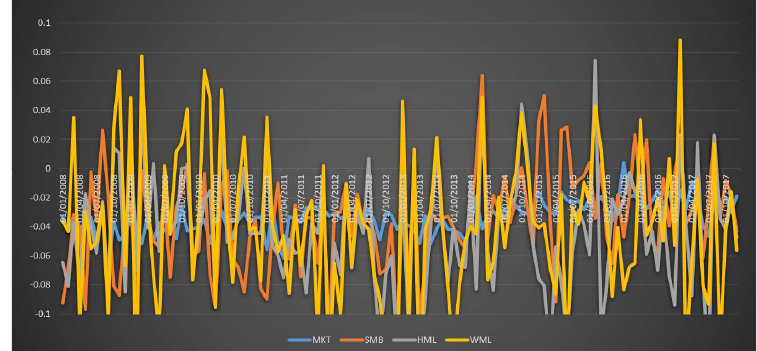
Figure 1. Distribution pattern of the four portfolio returns.